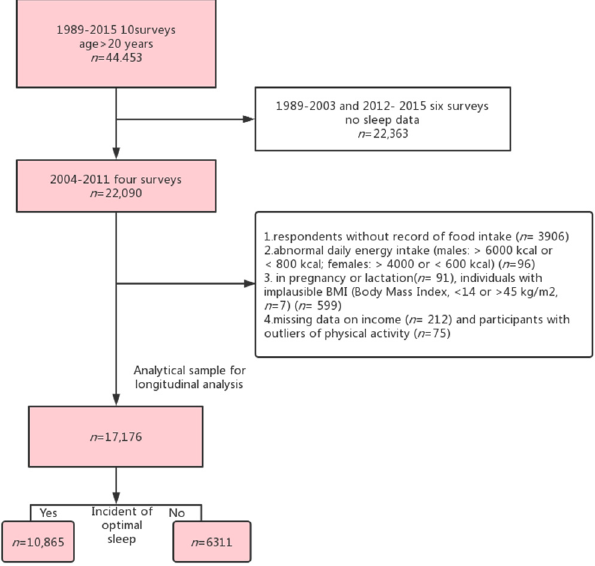
Figure 1. Flow chart of participants in the Selenium Intake and Sleep